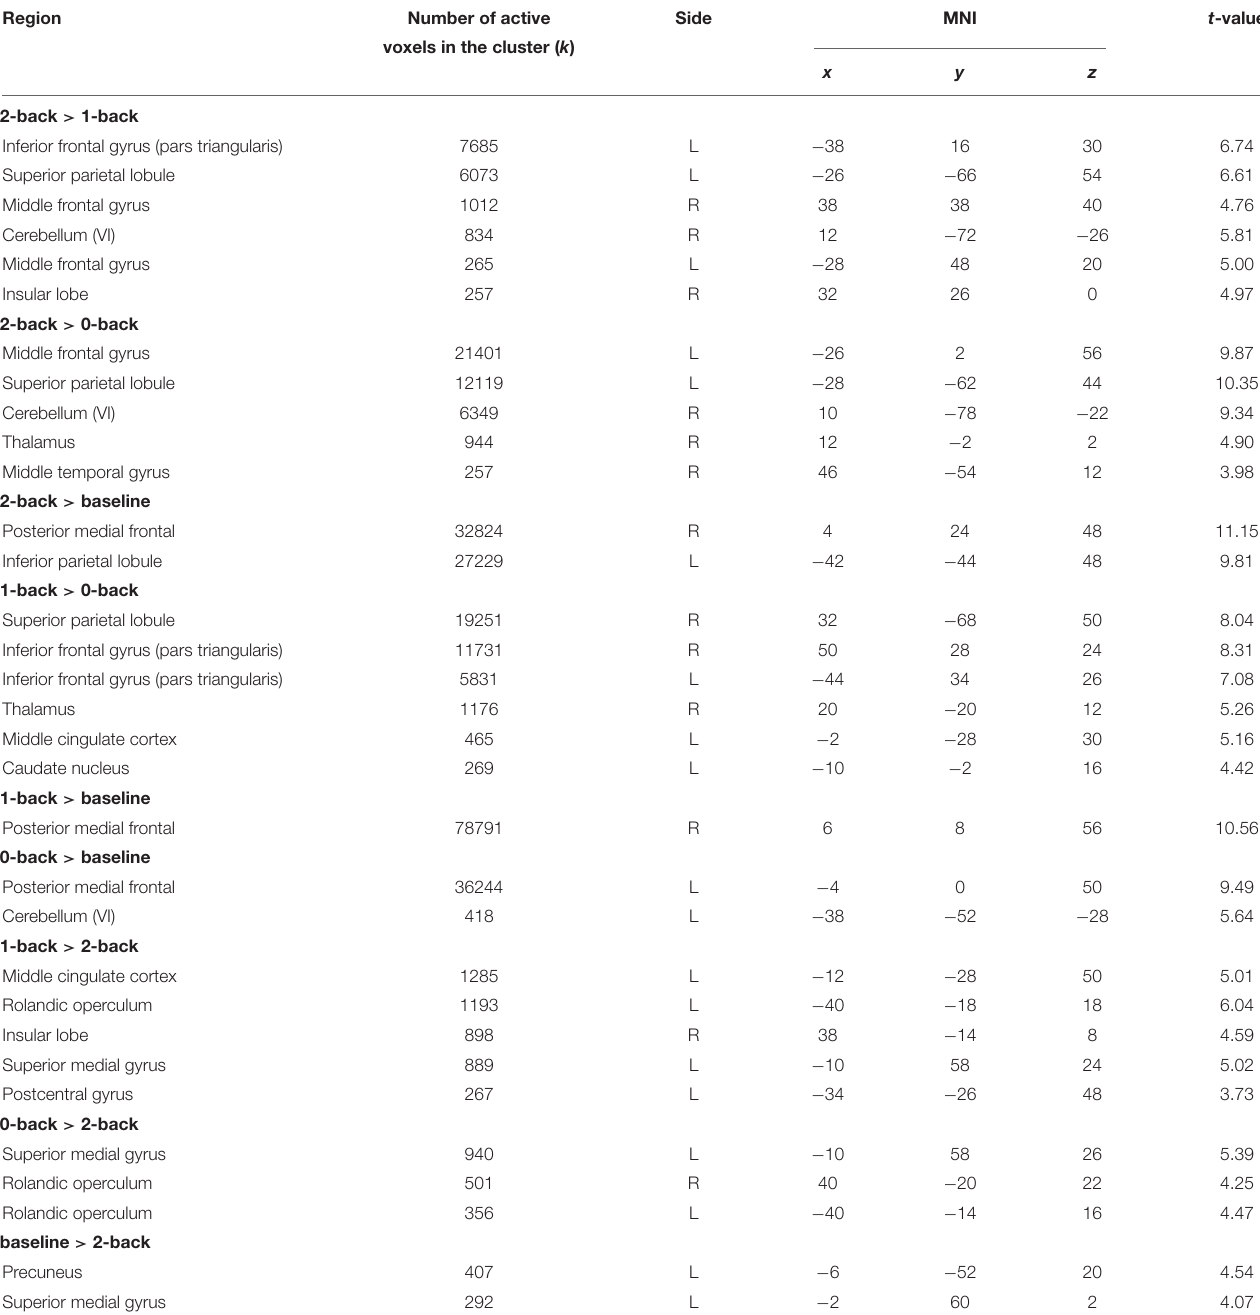
TABLE 5 | Brain activation corresponding to the main effect of condition in n-back tasks (whole-brain condition effects, all p < 0.05 [familywise error rate (FWE)-corrected]; only the maximum peak in grey matter is reported for each cluster). Region Number of active Side MNI t -value voxels in the cluster ( k